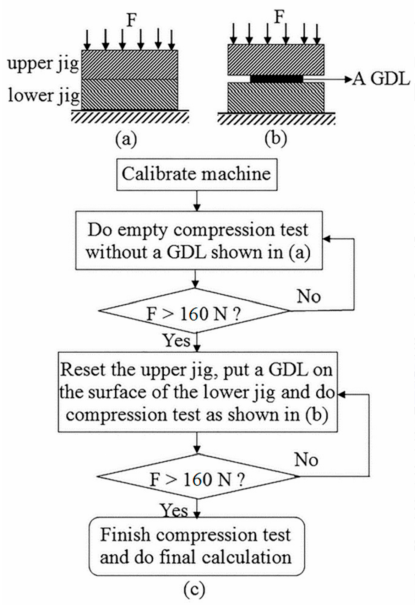
Figure 2. Test schematics ( a ) without and ( b ) with a GDL thin film specimen, and its compression test conducted as, in the chart ( c